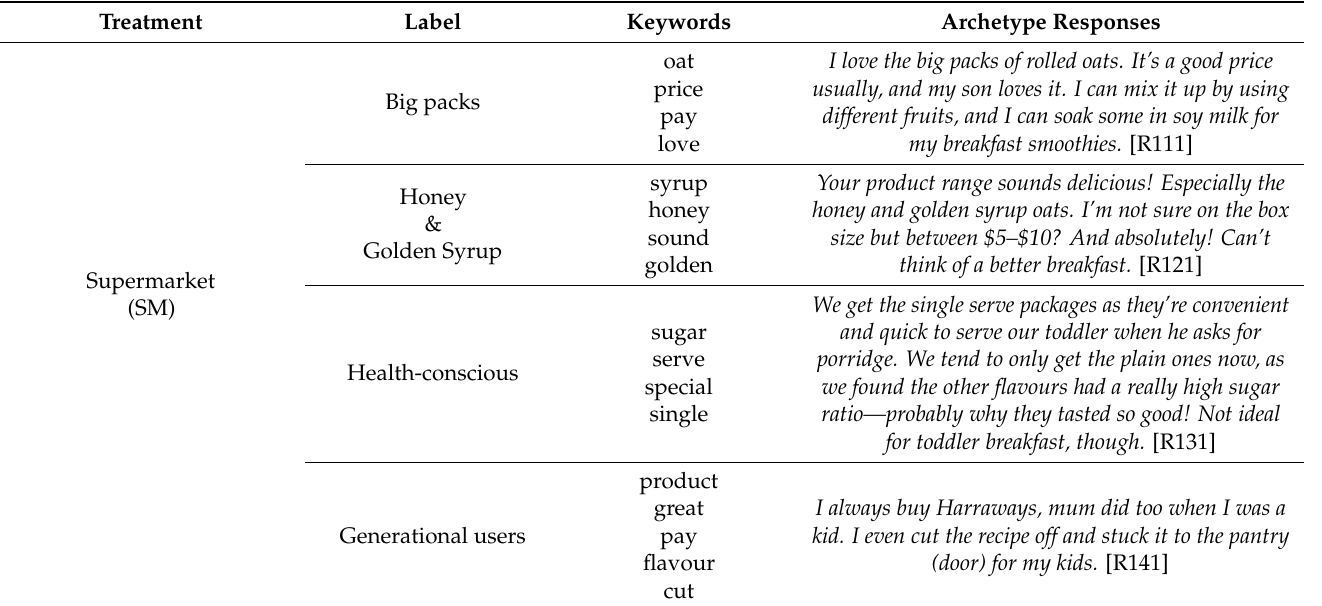
Table 5. Themes, key terms and archetype